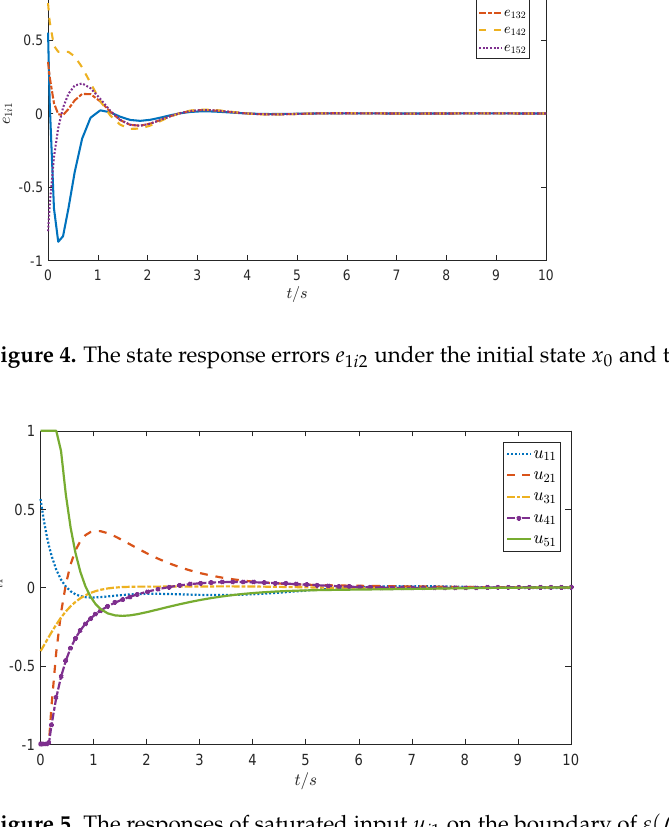
Figure 5. The responses of saturated input u i 1 on the boundary of ε ( L ⊗ Q − 1